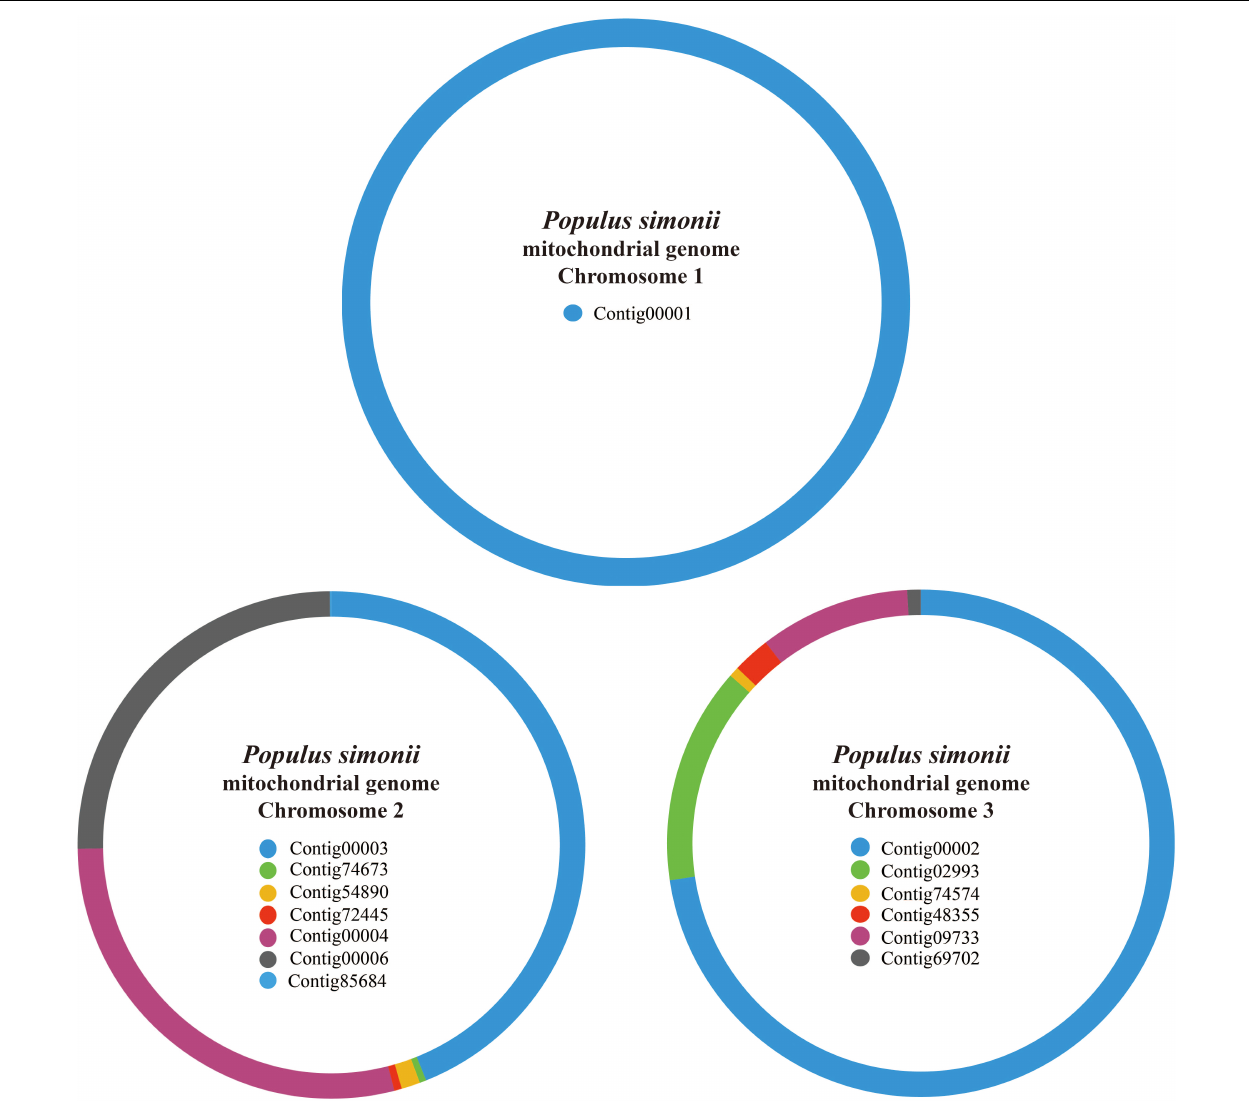
FIGURE 1 | The assembly graph of P. simonii mitogenome. The mt contigs chosen from Newbler are represented by different color blocks. The P. simonii mtChr1 is composed of only one contig, while mtChr2 and mt Chr3 are composed of seven and six contigs,